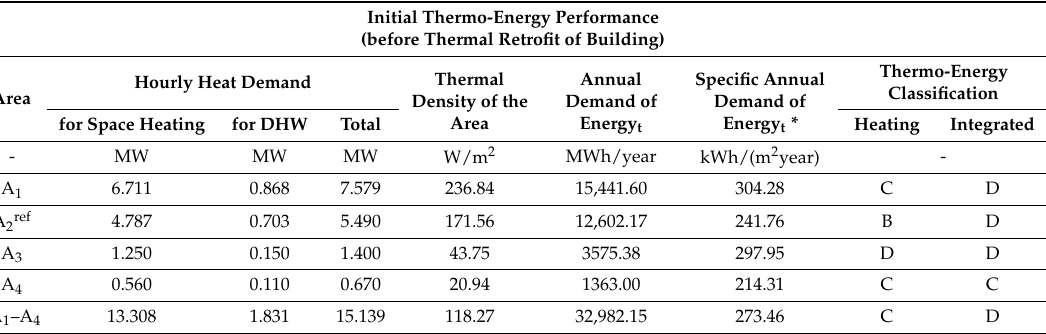
Table 4. Work Scenario no. 1, S1.